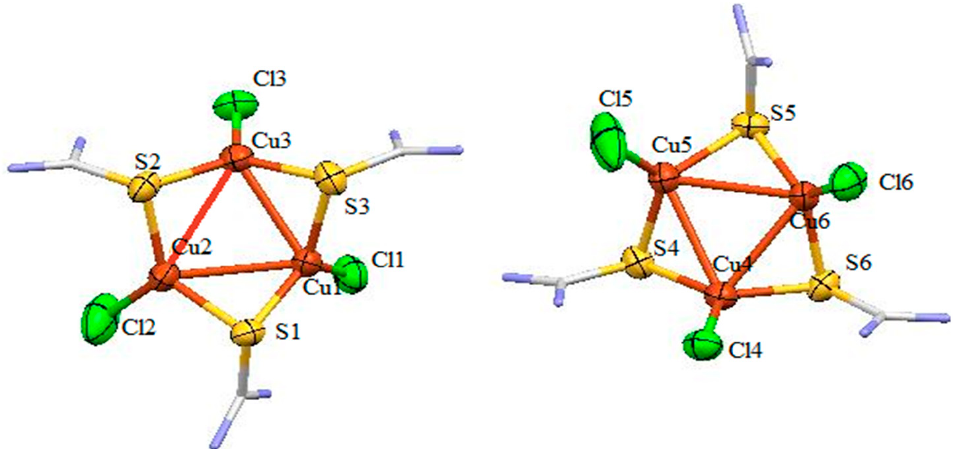
Figure 4. The molecular structure of compound 1 , only non-carbon atoms are numbered. Ellipsoids are drawn at 50% probability level; hydrogen atoms are omitted and carbons are represented by capped sticks.